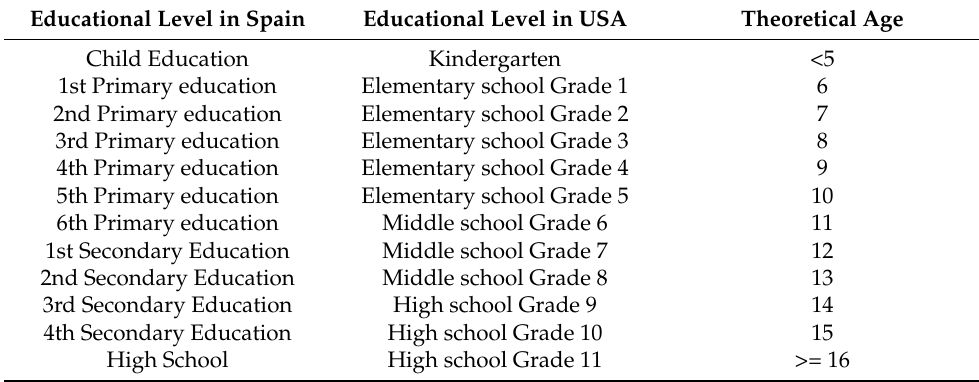
Table 1. Theoretical ages of students according to educational